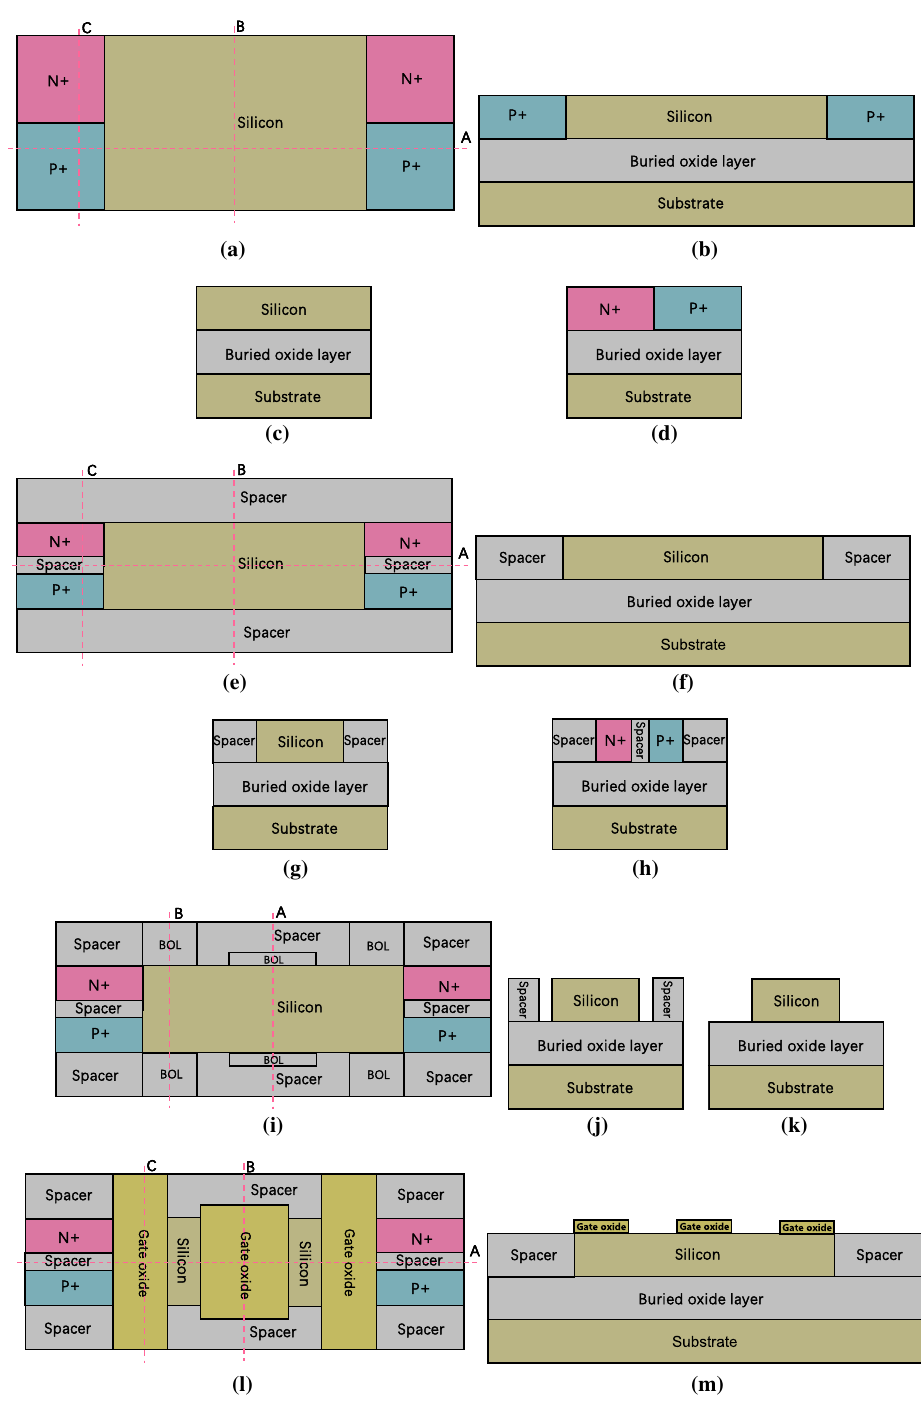
Figure 8. ( a ) top view of step 1, ( b ) cross view of Fig. 8a along cutline A, ( c ) cross view of Fig. 8a along cutline B, ( d ) cross view of Fig. 8a along cutline C, ( e ) top view of step 2, ( f ) cross view of Fig. 8e along cutline A, ( g ) cross view of Fig. 8e along cutline B, ( h ) cross view of Fig. 8e along cutline C, ( i ) top view of step 3, ( j ) cross view of Fig. 8i along cutline A, ( k ) cross view of Fig. 8i along cutline B, ( l ) top view of step 4, ( m ) cross view of Fig. 8l along cutline A, ( n ) cross view of Fig. 8l along cutline B, ( o ) cross view of Fig. 8l along cutline C, ( p ) top view of step 5, ( q ) cross view of Fig. 8p along cutline A, ( r ) cross view of Fig. 8p along cutline B, ( s ) cross view of Fig. 8p along cutline C, ( t ) cross view of Fig. 8p along cutline D, ( u ) top view of step 6, ( v ) cross view of Fig. 8 u along cutline A, ( w ) cross view of Fig. 8u along cutline B, ( x ) top view of step 7, ( y ) cross view of Fig. 8x along cutline A, ( z ) cross view of Fig. 8x along cutline B, ( aa ) cross view of Fig. 8x along cutline C, ( bb ) cross view of Fig. 8x along cutline D, ( cc ) top view of step 8, ( dd ) cross view of Fig. 8cc along cutline A, ( ee ) cross view of Fig. 8cc along cutline B, ( ff ) cross view of Fig. 8cc along cutline C, ( gg ) cross view of Fig. 8cc along cutline D, ( hh ) top view of step 9, ( ii ) cross view of Fig. 8hh along cutline A, ( jj ) cross view of Fig. 8hh along cutline B, ( kk ) cross view of Fig. 8hh along cutline C, ( ll ) cross view of Fig. 8hh along cutline D, ( mm ) top view of step 10, ( nn ) cross view of Fig. 8mm along cutline A, ( oo ) cross view of Fig. 8mm along cutline